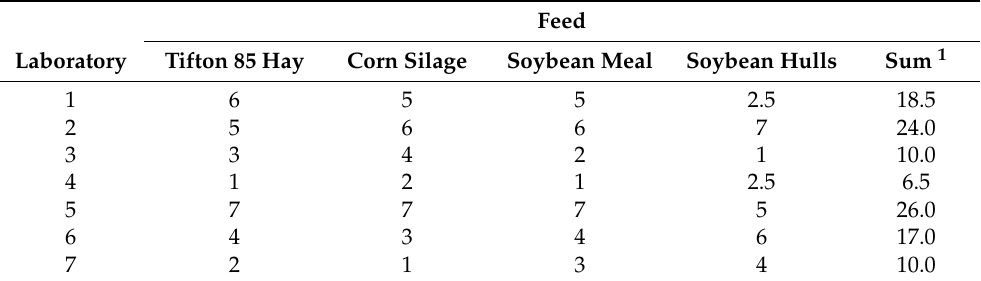
Table 3. Ranking of the empirical best linear unbiased predictors for the effects of laboratories on in vitro dry matter digestibility of different feeds.